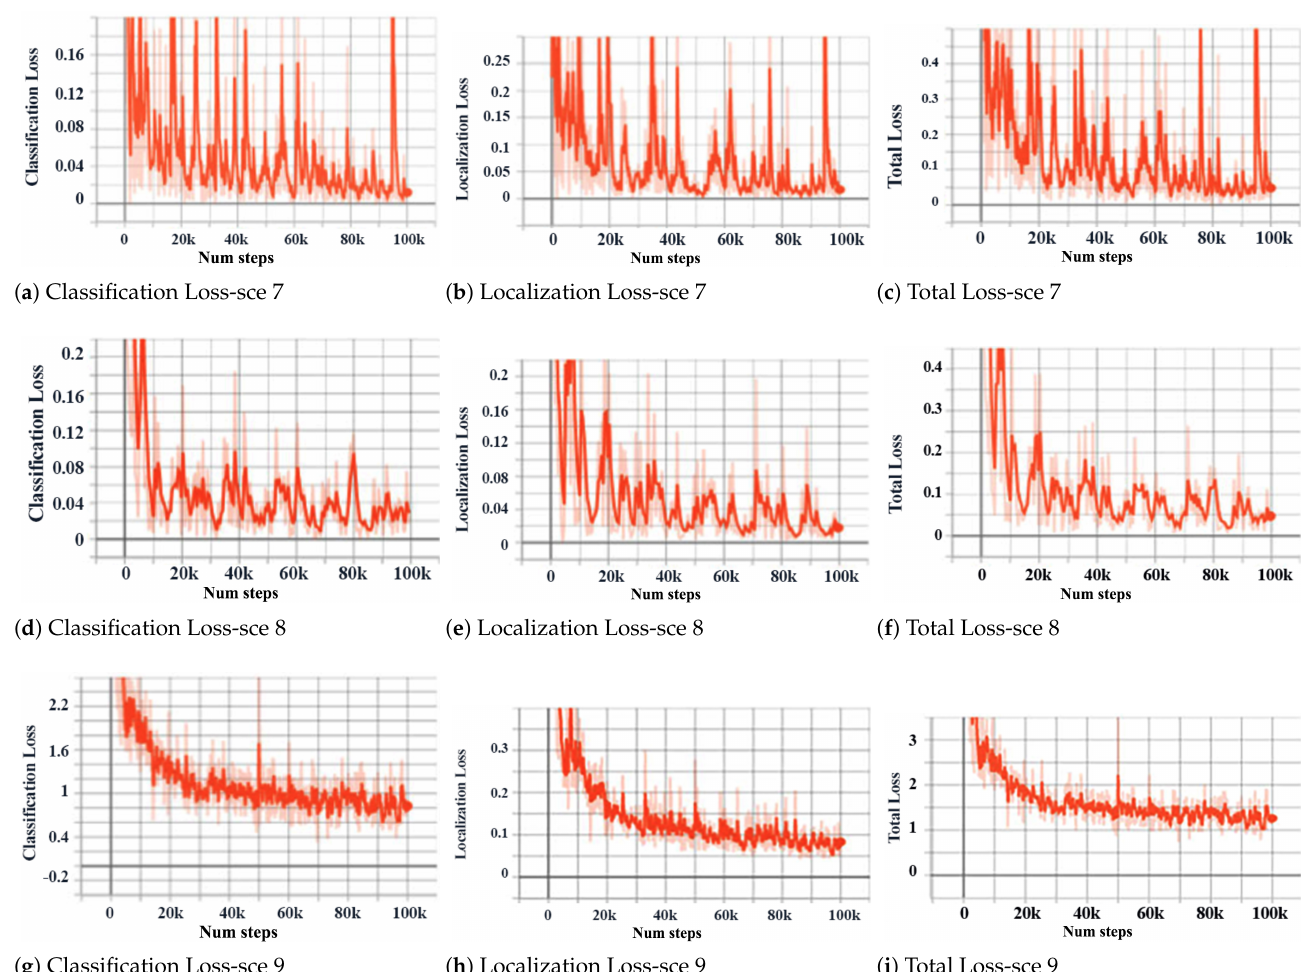
Figure 15. Histograms of the loss values for Scenarios 7, 8, and 9.